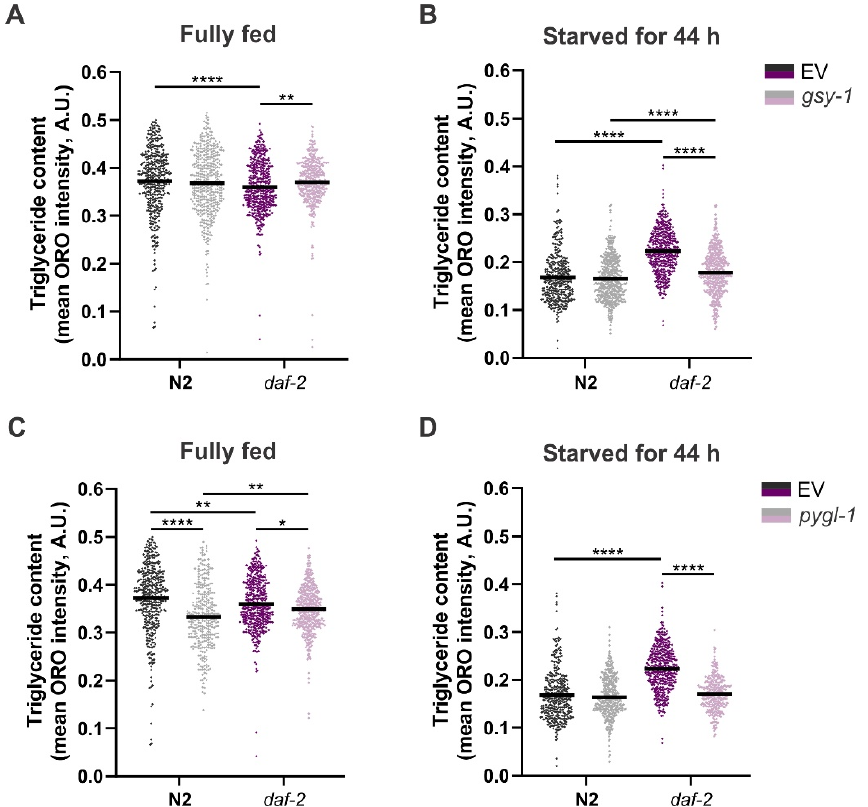
Figure 4. The effect of suppressing glycogen synthesis ( A , B ) and breakdown ( C , D ) on triglyceride levels in wild-type N2 and daf-2(e1370) mutants in fully fed condition ( A , C ) and after 44 h of starvation ( B , D ). In all graphs, three independent replicates are plotted together, with indicated mean. Each data point represents a mean ORO intensity for a single worm. EV—empty vector control. * p ≤ 0.05, ** p ≤ 0.01, **** p ≤ 0.0001 (Kruskal–Wallis test).